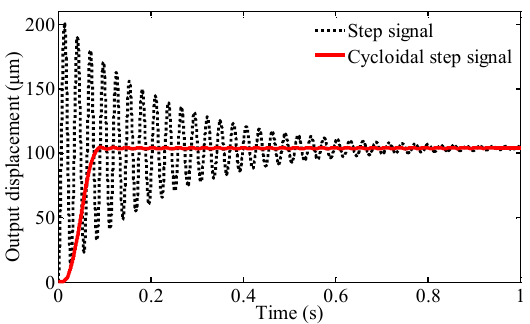
Figure 15. Responses of the compliant platform to different signals in the X direction.